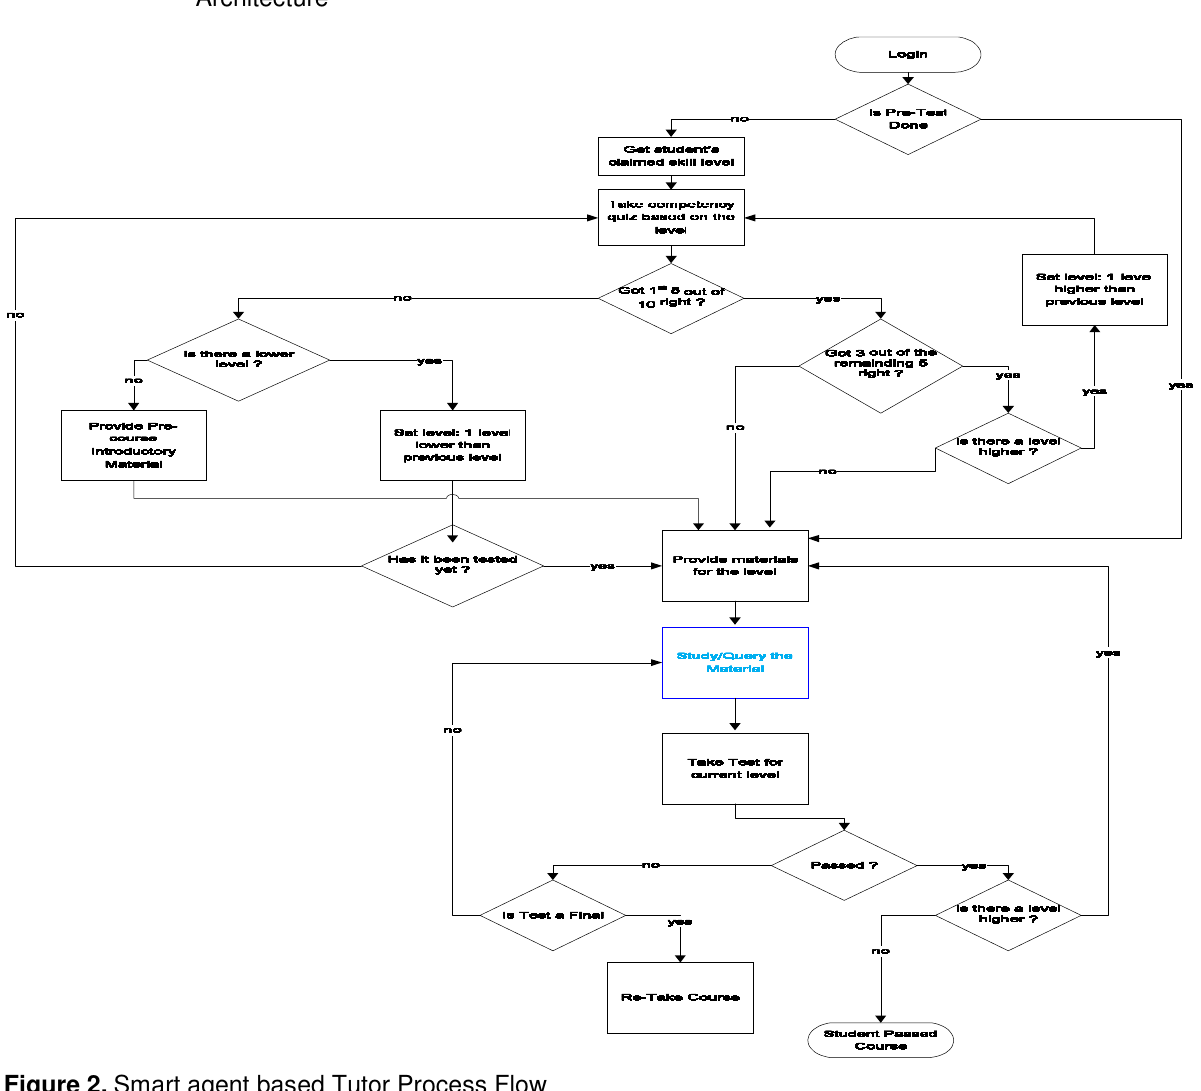
Figure 2. Smart agent based Tutor Process